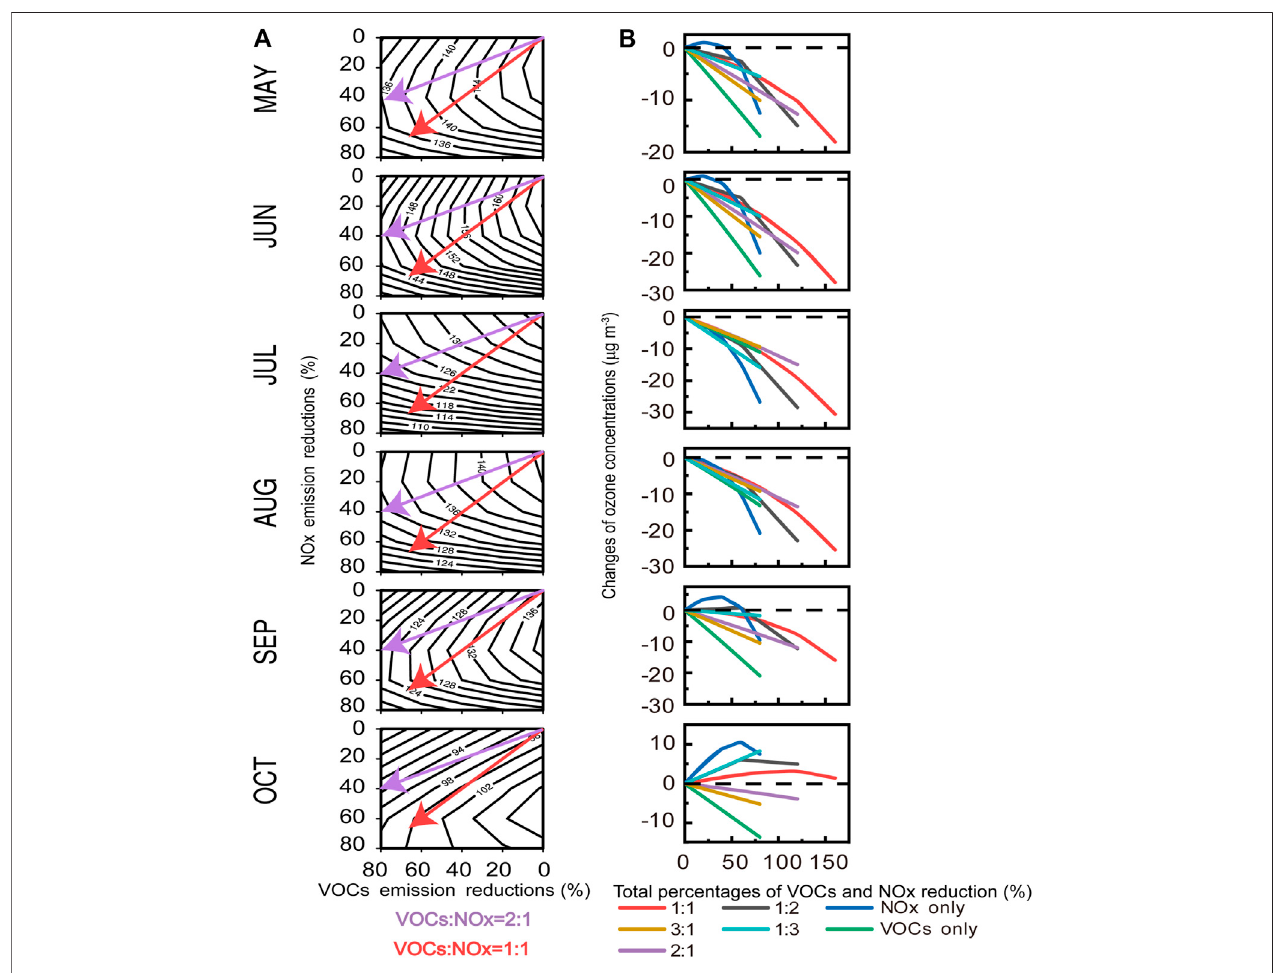
FIGURE 4 | (A) Empirical kinetic modeling approach (EKMA) isopleths of monthly mean daily maximum 8 h average (MDA8) ozone concentrations ( μ g m − 3 ) in Nanjing for May – October 2017. Red and purple arrows represent VOCs and NO x anthropogenic emissions simultaneously reduced by 1:1 and 2:1, respectively. (B) Differences in monthly mean MDA8 ozone concentrations between sensitivity simulations and standard model simulation in Nanjing for May – October 2017. Sensitivity simulations include VOCs anthropogenic emissions reduction only, NO x anthropogenic emissions reduction only, and reduction of VOCs and NO x